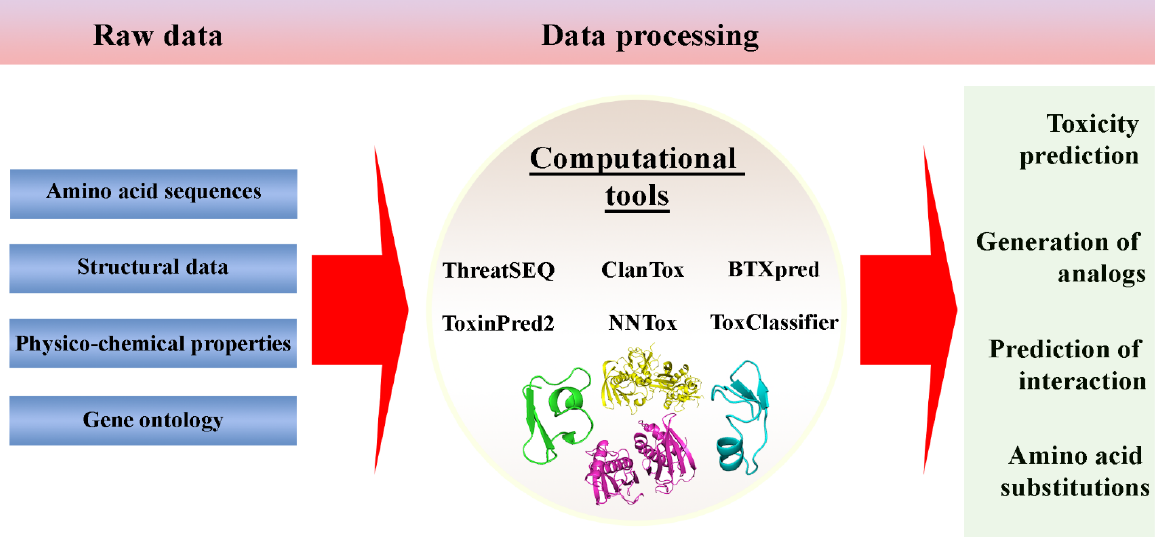
Figure 2. Machine-learning methods based tools for protein toxicity prediction.